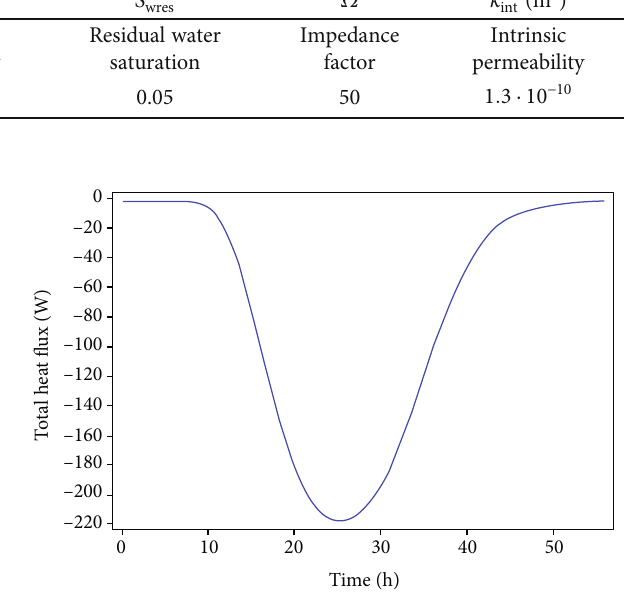
Figure 4: Total heat fl ux. Total heat fl ux exiting the system via the out fl ow boundary as a function of